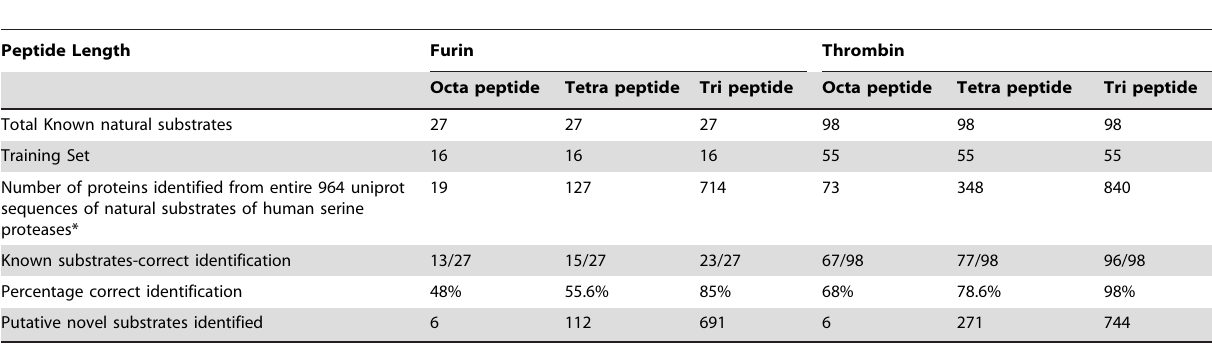
Table 2. Identification of reported substrates of furin and thrombin using Query Sequence Set.